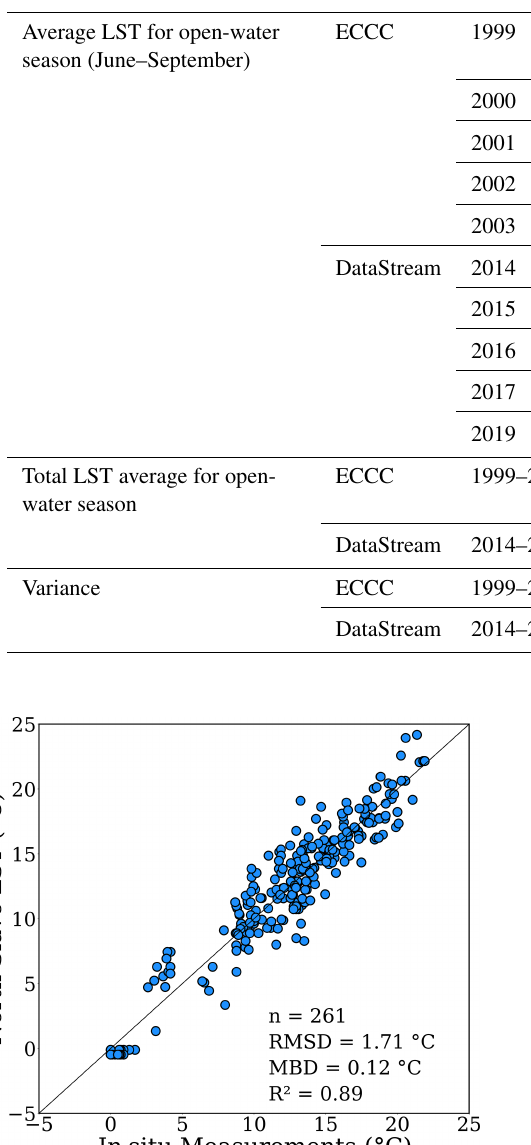
Table 2. Comparison of yearly average LST, average LST, and variance between North Slave LST and in situ LST. Statistical parameters